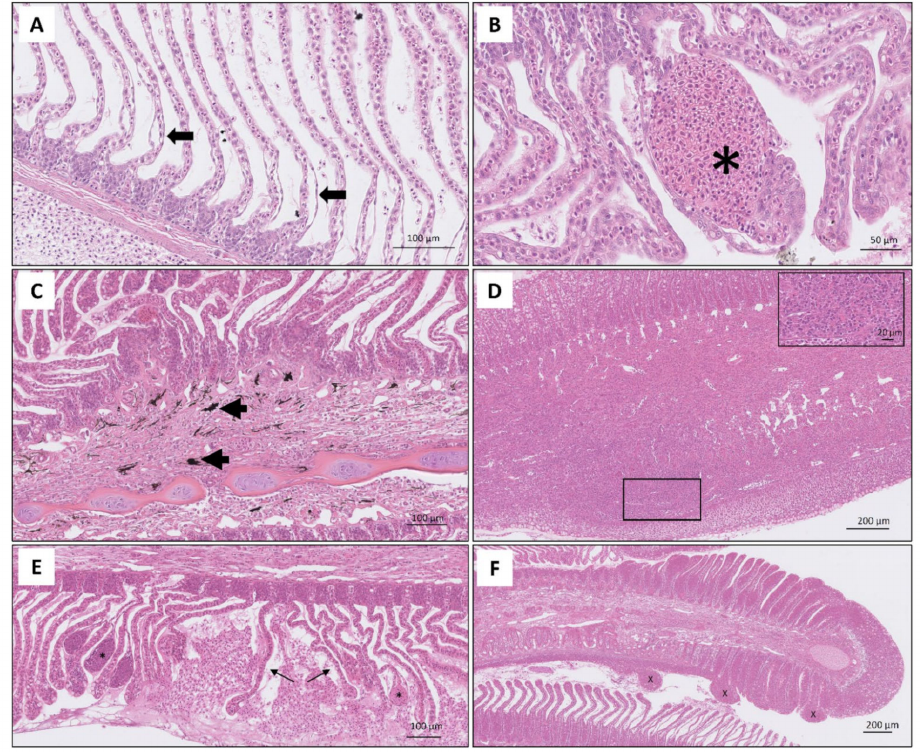
Figure 4. Histomicrographs of H & E-stained sections of gills showing various degrees of pathology. ( A ) Lamellae of the epithelium showing epithelial lifting; ( B ) telangiectasis resulting from rupture of pillar cells and accumulation of blood; ( C ) moderately affected gill with influx of melanin containing cells (arrowed) in the gill filament; ( D ) evidence of fusion of lamellae and formation of a diffuse granulomatous lesion along the mid length of the gill filament, Note higher magnification view of the rectangle for dense accumulation of eosinophilic granular cells and mononuclear leukocytes. No melanin containing cells were noted ( E ) degenerative lesion consists of telangiectasis (asterisk) and rupture of lamellae (arrow); ( F ) extensive hyperplastic lesions and formation of papillary lesions (x) at distal end of gill